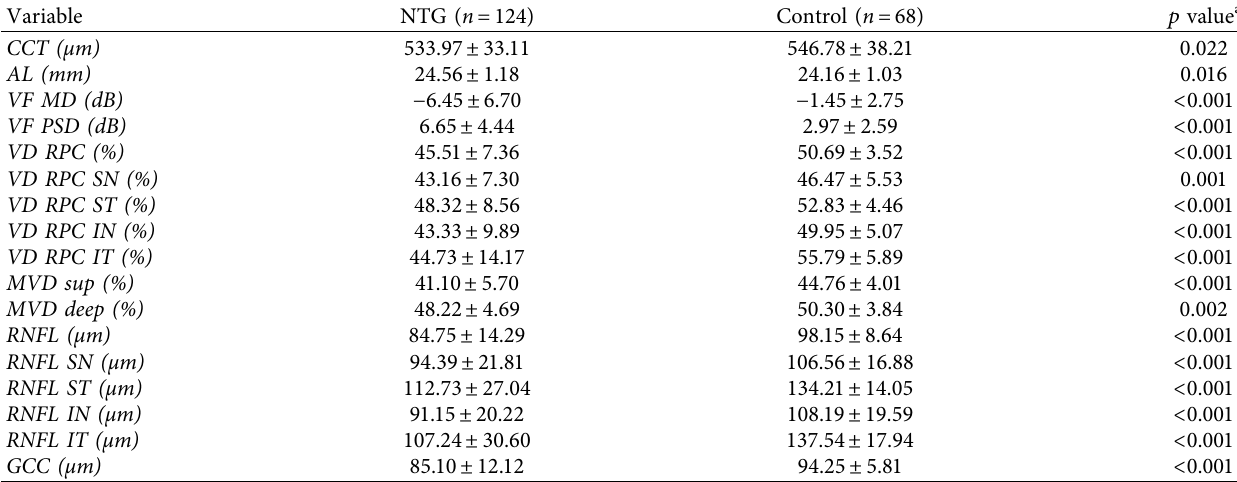
Table 2: Clinical parameters of the NTG and control